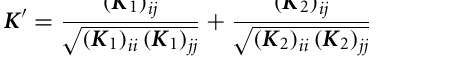
support vector machine; K’, integrated kernel matrix; f (x), SVM decision function; w (cid:6) , optimum vector of predictive weights obtained using K (cid:6) ; w K , optimum weight coefficient assigned to each base